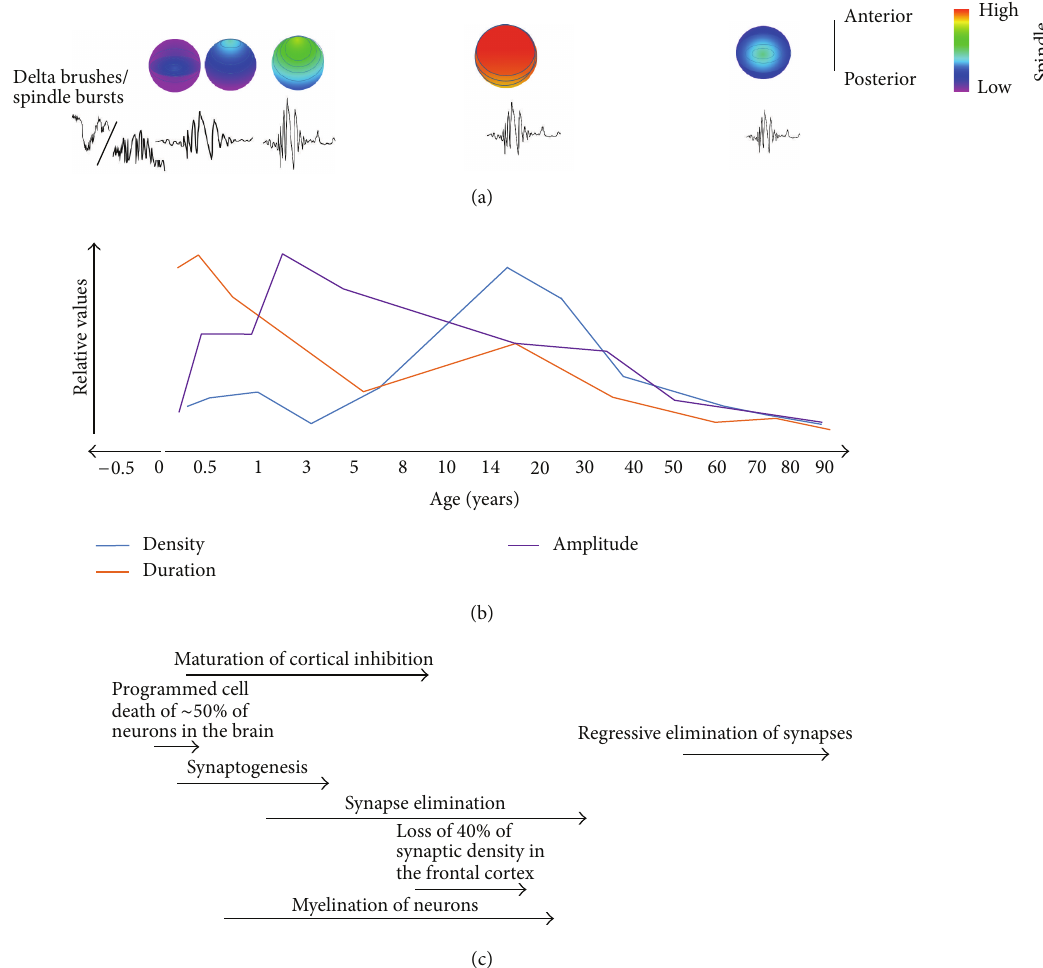
Figure 2: Changes in spindle form across the lifespan. (a) Heat maps depict topographical spindle density during early development, adolescence, and aging. Spindles are initially seen over central areas of the brain and gradually develop over frontotemporal areas during the first year of life [11]. During adolescence, density reaches a relative maximum with equal distribution across frontal, central, and parietal leads. In aging, there is a return to the same pattern seen earlier in development, with highest density at central leads [12]. Below the heat maps are representations of spindle morphology at these ages. (b) Sleep spindle density ( blue trace ) increases throughout early development, peaking during puberty and steadily declining from adolescence to old age [13, 14]. Duration of sleep spindles ( orange trace ), on the other hand, peaks early in life, and then generally declines over the lifespan. Spindle amplitude ( purple trace ) is relatively small early in development, increasing to maximum values over the first year of life, and then steadily declines until old age [15]. (c) Neurodevelopmental